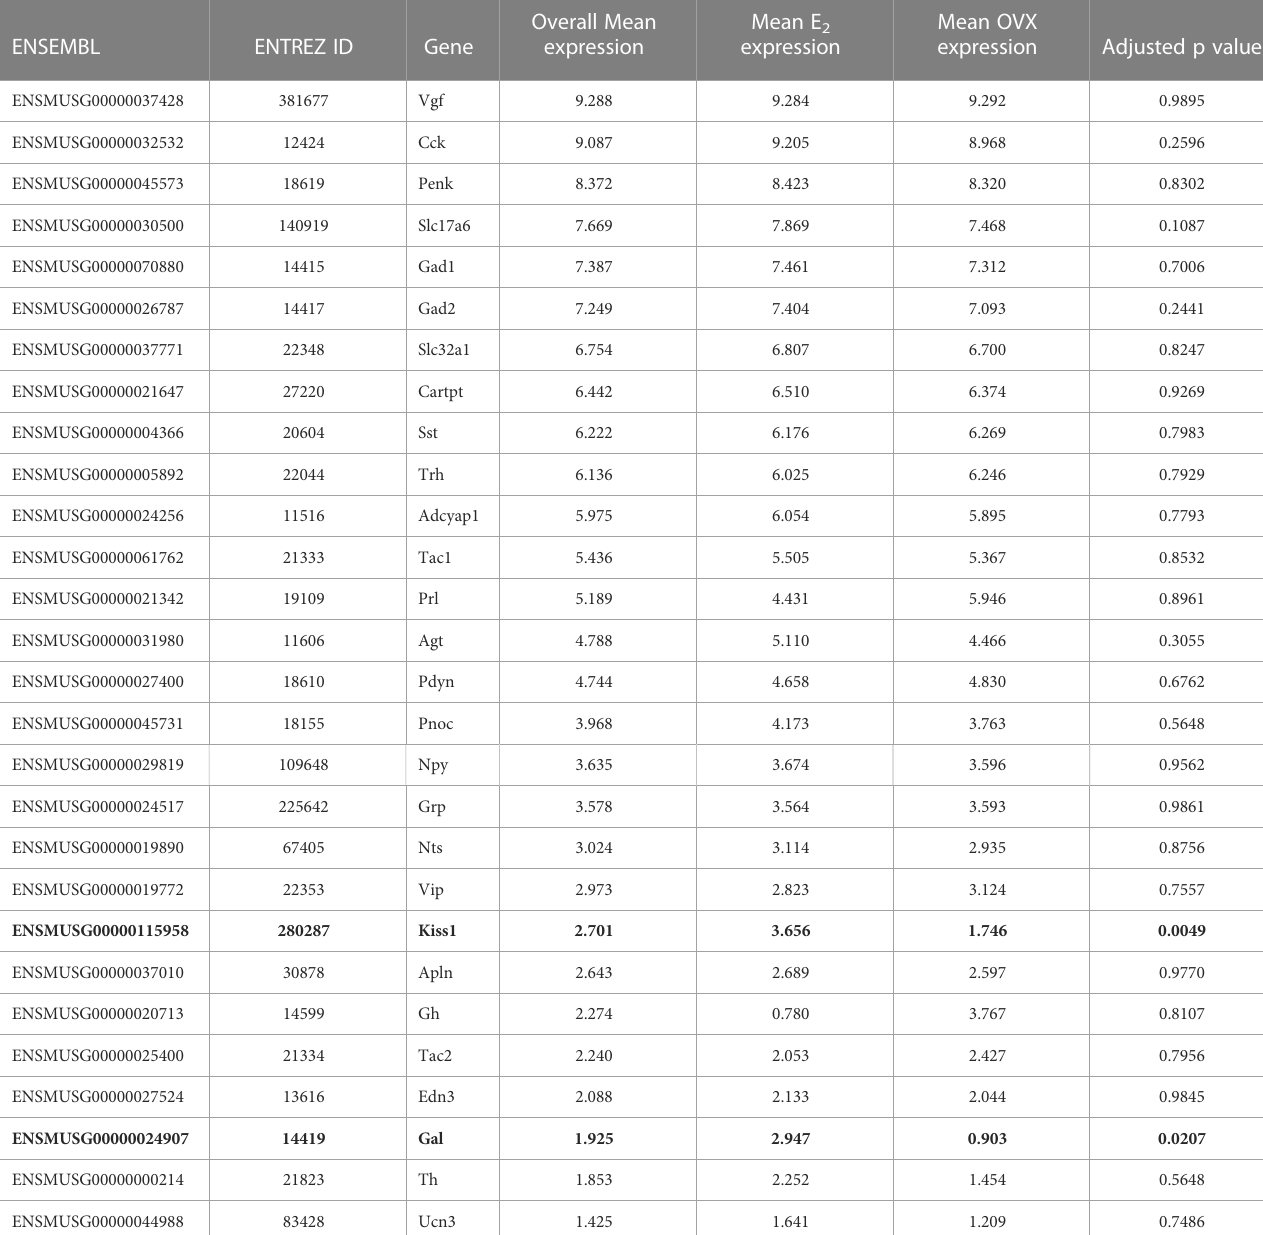
TABLE 2 Notable ligand (or their related enzyme) transcripts identi fi ed in female MeA Kiss1 cells.